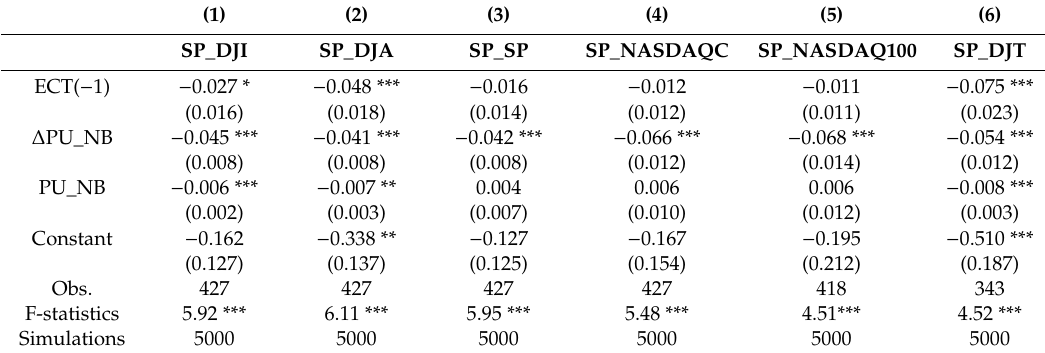
Table A2. Robustness: alternative measures of